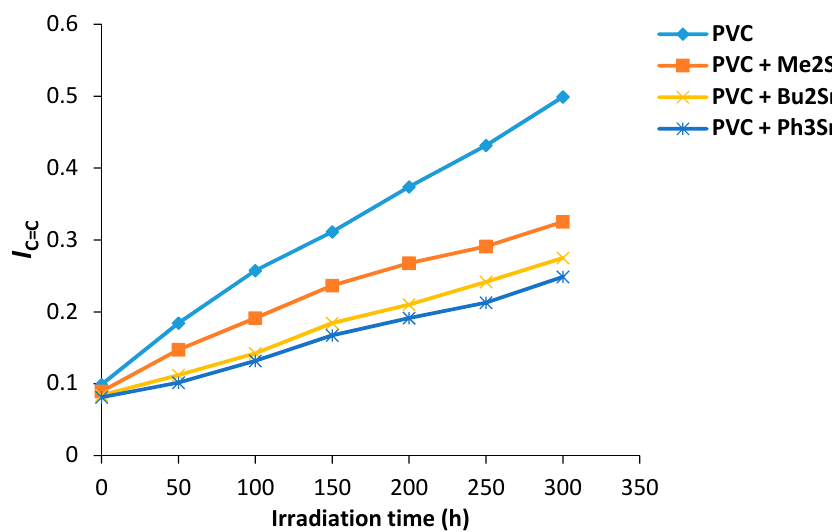
Figure 5. Changes in the I C=C index for PVC films versus irradiation time.